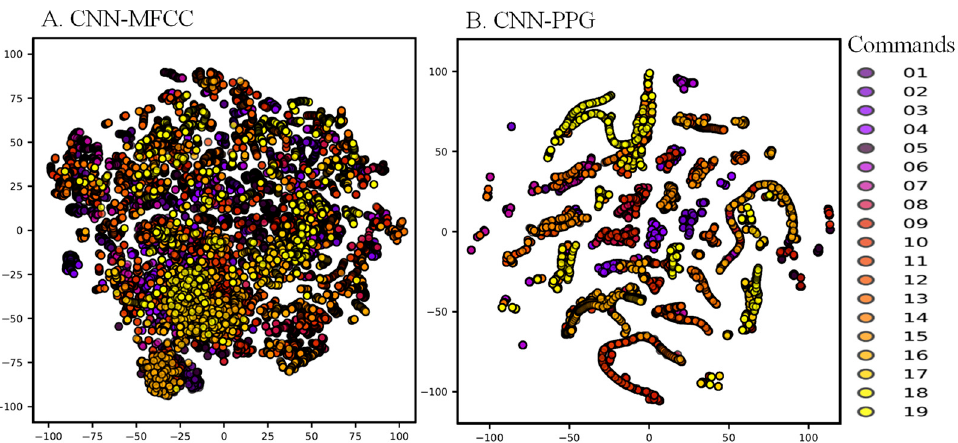
Figure 2. The t -SNE analysis of ( A ) CNN–MFCC model and ( B ) CNN–PPG model. In the CNN–PPG groups, the t -SNE of 19 commands were separate, distinct from the CNN–MFCC groups. Note: the labels “01” to “19” are the commands of close, up, down, previous, next, in, out, left, right, home, one, two, three, four, five, six seven, eight, and nine, respectively.